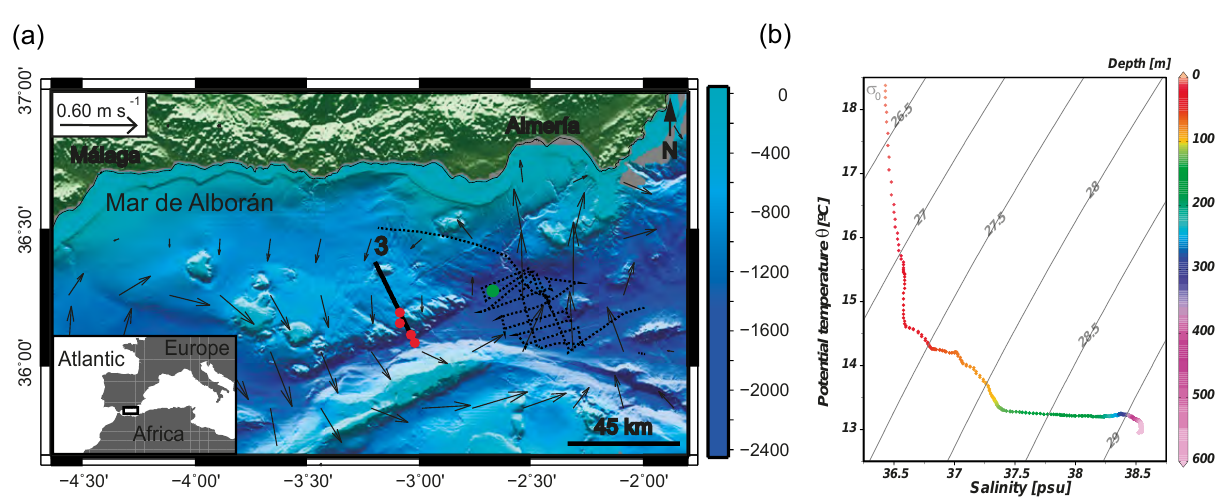
Figure 1. (a) Bathymetric map of the Alboran Sea and location of the data used in the study. HR-MCS profile acquired during the IMPULS 2006 experiment (black line labeled 3) from expendable bathythermograph (XBT) profilers (red circles) and an expendable conductivity– temperature–depth (XCTD) probe (green circle). Acoustic Doppler current profiler (ADCP) lines (black dotted line). Geostrophic velocity for 17 May 2006 (gray arrows). (b) Temperature–salinity diagram from the XCTD probe. σ 0 is the potential density in kilograms per cubic meter. Color scale indicates